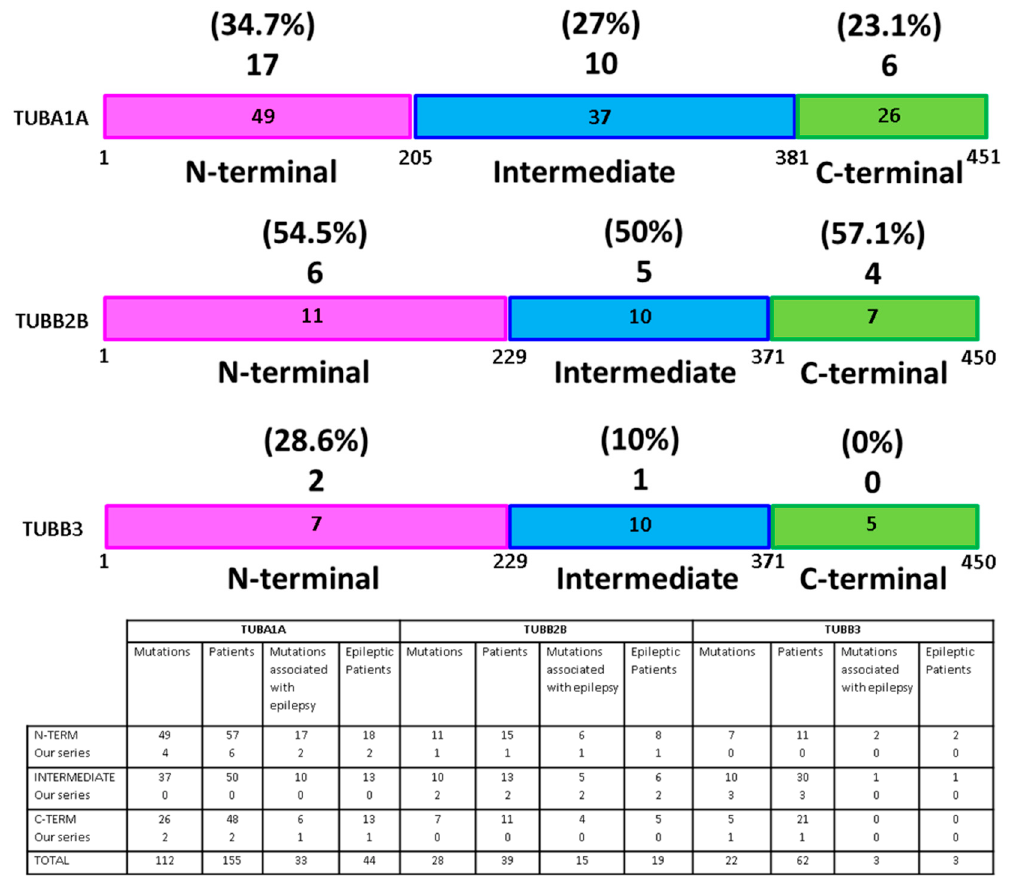
Figure 3. Schematic representations of the functional domains of TUBA1A, TUBB2B and TUBB3 . The numbers in the boxes show how many mutations are described for each tubulin domain by distinguishing literature and our series, while above the protein schemes are reported the number of mutations associated with epilepsy and the corresponding percentage.